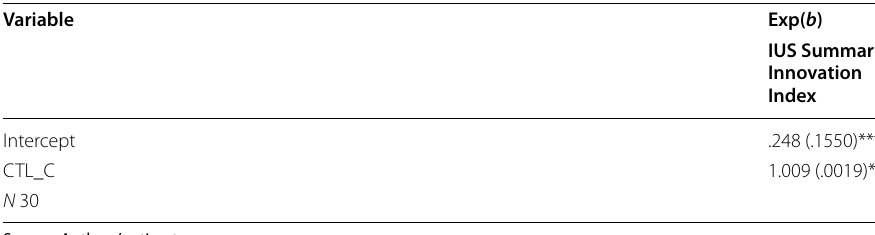
Source: Authors’ estimate *** Significant at 1%